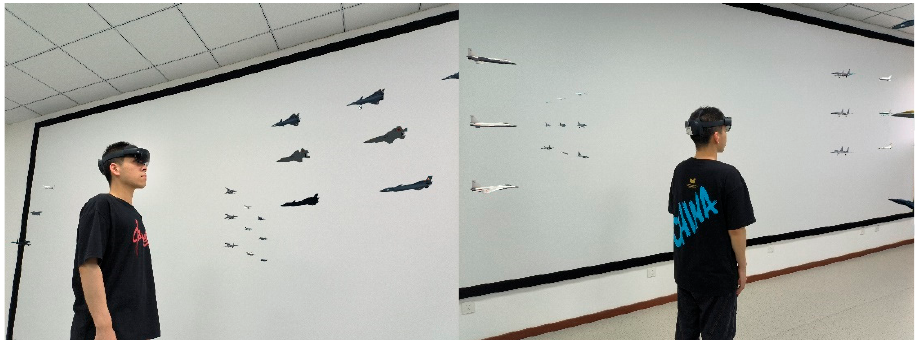
Figure 9. The virtual-real diagram of an integrated task of auxiliary target localization incorporating auditory elements.